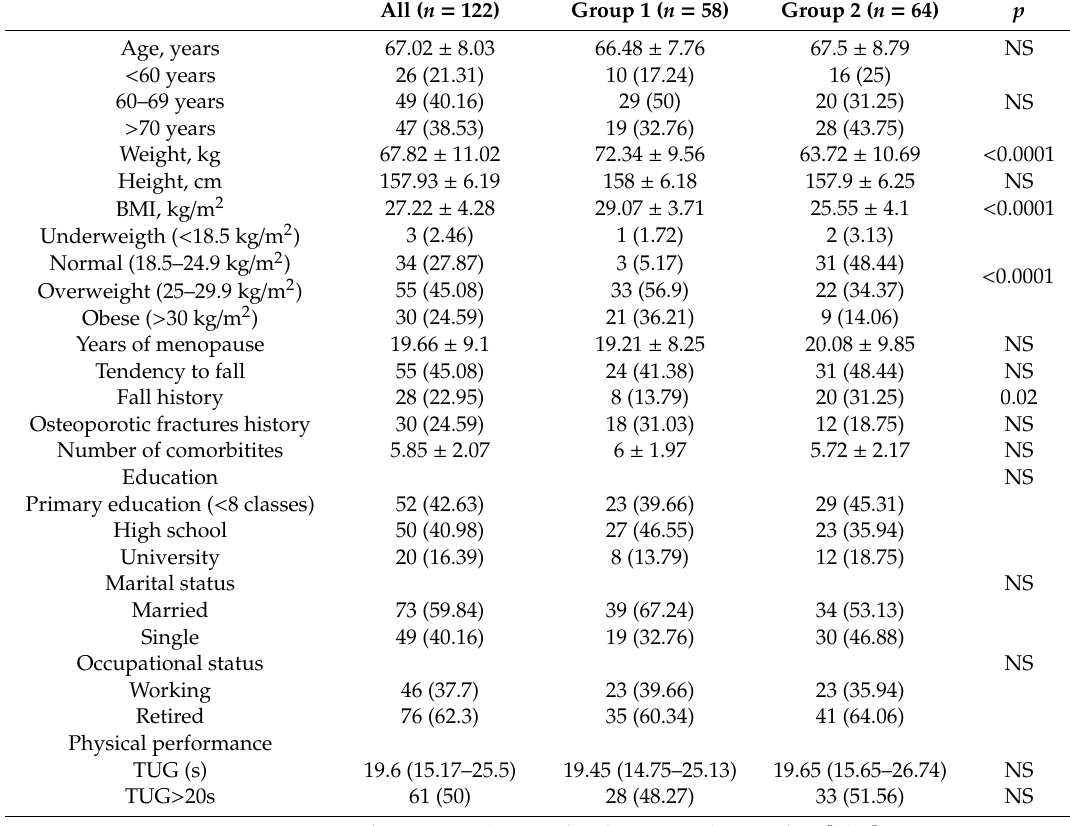
Table 1. Socio-Demographic and Clinical